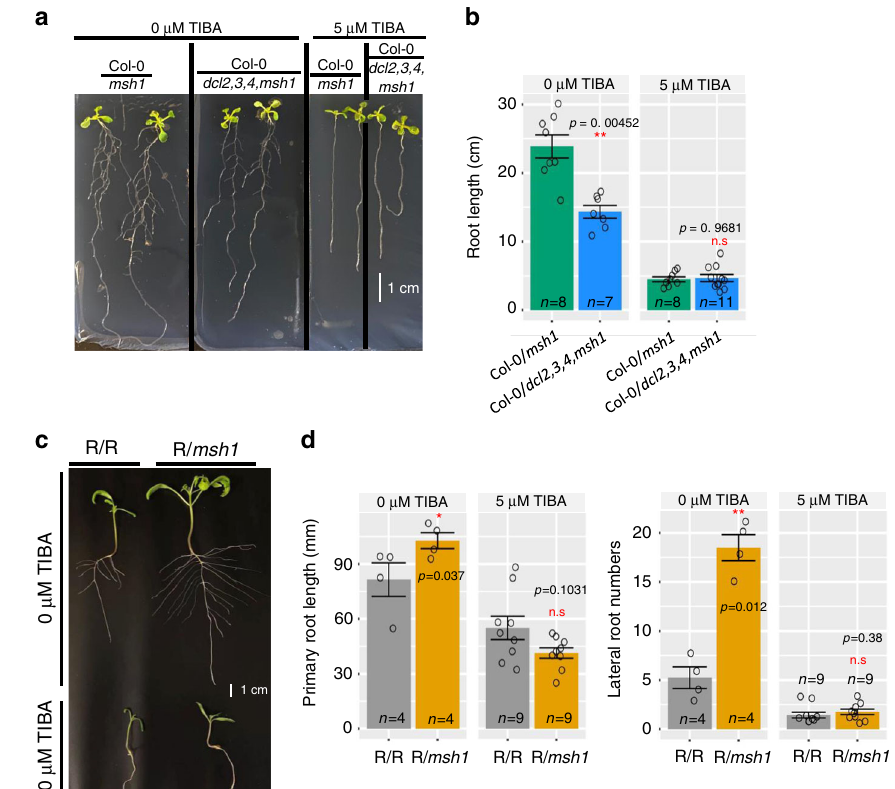
Fig. 6 The msh1 graft progeny root phenotype and TIBA treatment. a Arabidopsis Col-0/Col-0 and Col-0/ msh1 graft progeny ( fi rst generation) growing on 0.5 M MS medium with and without 2,3,5-Triiodobenzoic acid (TIBA, auxin inhibitor) treatment. Photo shows seedlings at 12 days after planting. b Total root length (cm), including primary root and all lateral roots of Arabidopsis Col-0/Col-0 and Col-0/ msh1 graft progeny with and without 5 μ M TIBA treatment. The phenotype for c primary root length and d lateral root number for tomato Rutgers/Rutgers (R/R) and Rutgers/RNAi -MSH1 (R/ msh1 ) graft progeny (third generation) growing on 0.5 M MS medium with and without TIBA treatment. Photo shows seedling at 19 days after planting. b , d Bars represent means± SE, n represents number of plants in each population. The Mann – Whitney U -test with two-sided alternative hypothesis was used to test the signi fi cance of the difference of mean in each comparison. Signi fi cance codes: * p < 0.05, ** p < 0.01, *** p < 0.001, NS, no signi fi cance. Source data underlying b , d are provided as a Source Data fi